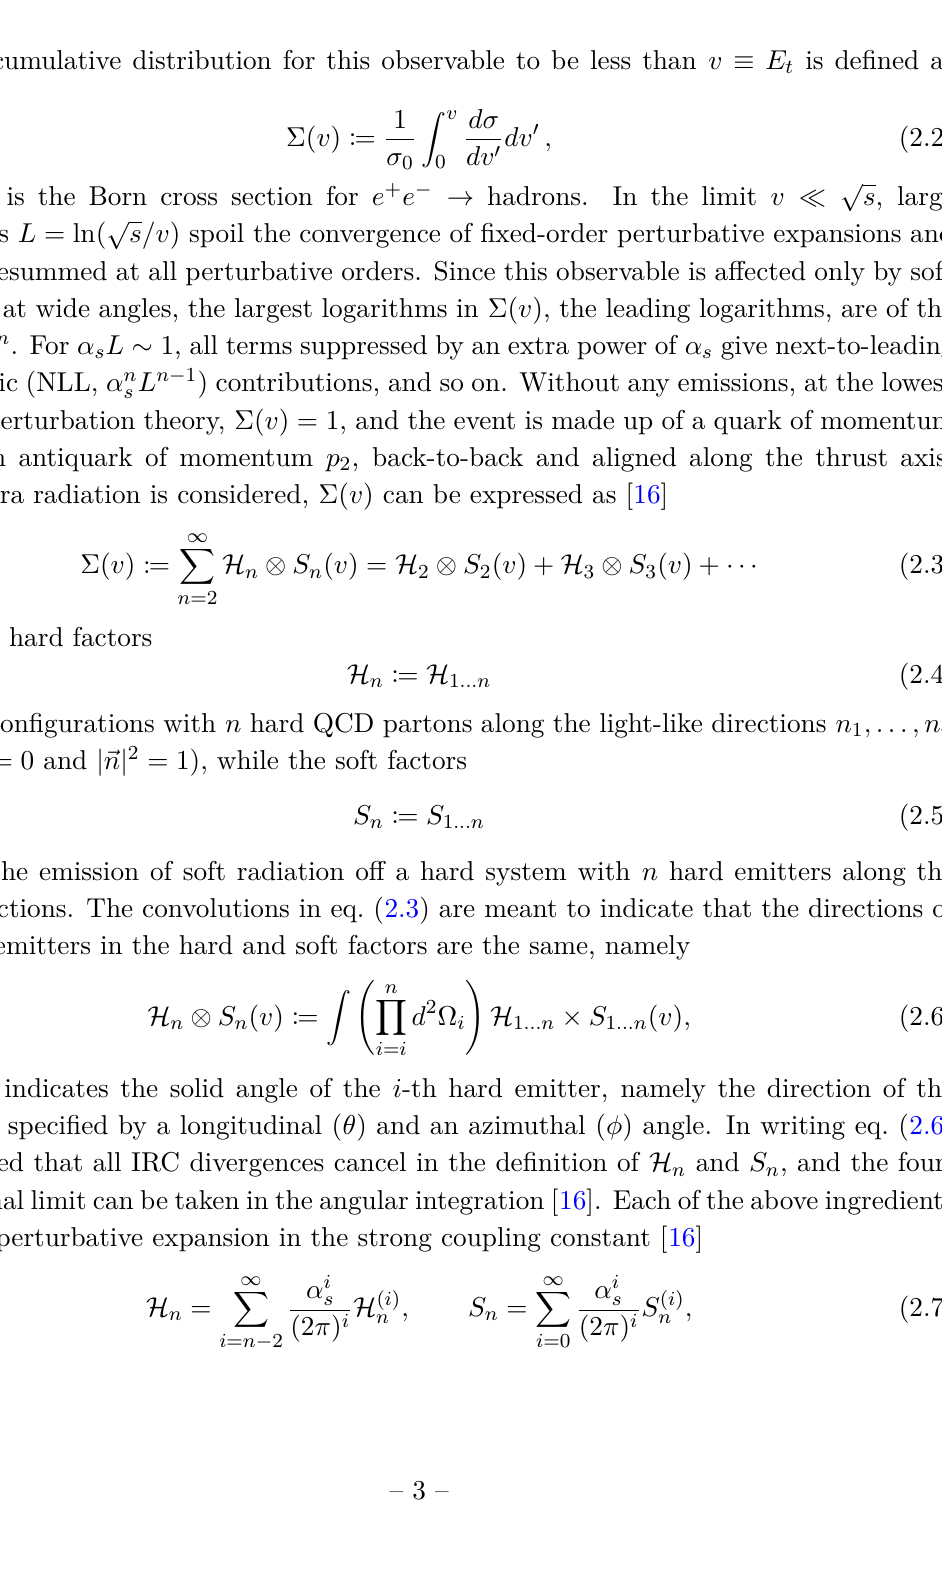
Figure 1 . The rapidity slice where the measurement is